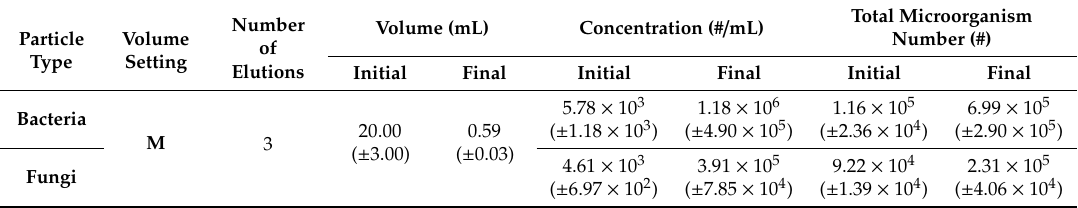
Table 2. Initial and final concentrations of the bacteria and fungi, in an outdoor environment, that were concentrated using the CP-150. The microorganism concentrations were determined using acridine orange staining microscopy. The data represent the averages of three repeated measurements, and the error bars represent one standard deviation.